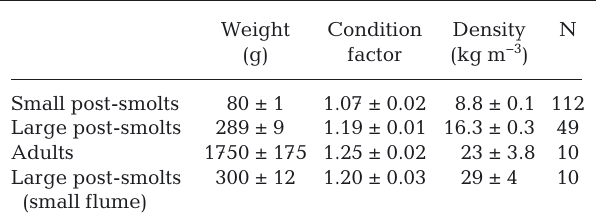
Fish were transferred from the holding tank to their swim tunnel during the afternoon on the day before measurements after being fed their daily ration. All